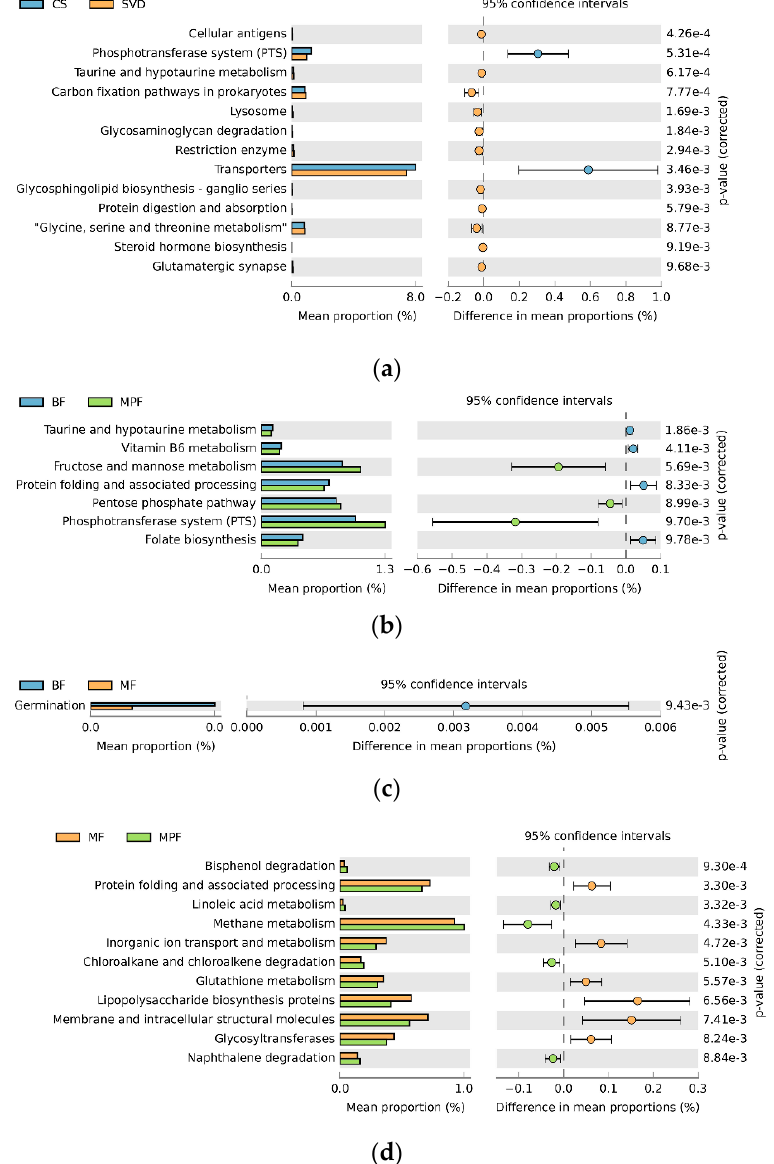
Figure 8. PICURSt function prediction of infant gut microbiota in different delivery modes and feeding methods. ( a ) Delivery modes; ( b , c , d ) Feeding methods.